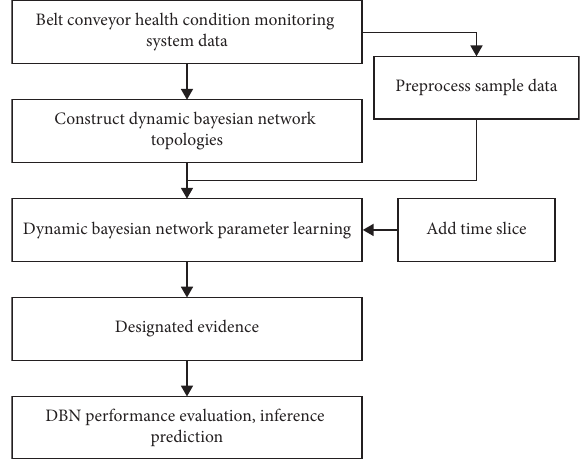
Figure 2: Dynamic bayesian network modeling